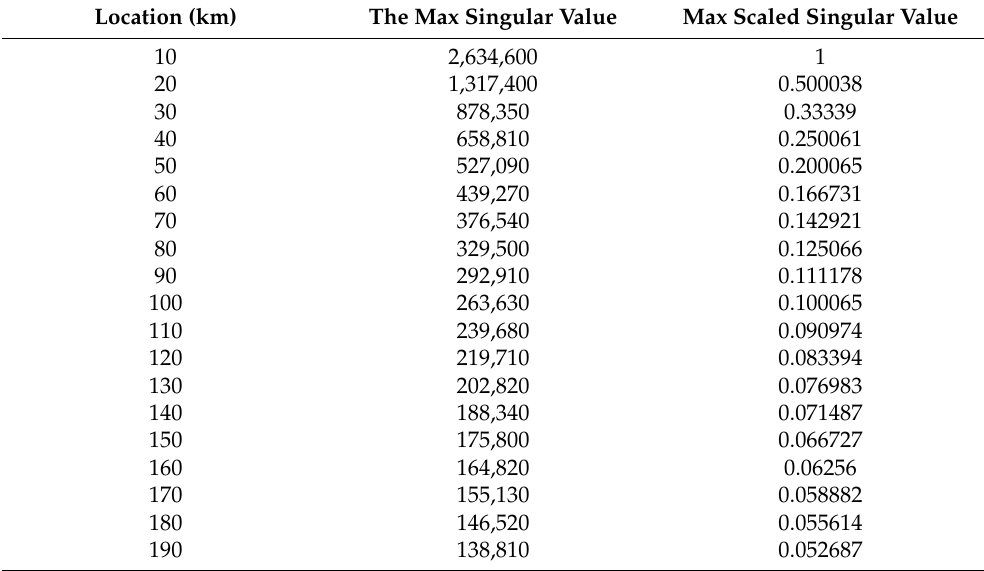
Table 4. The maximum singular and its scaled values for LG fault at 19